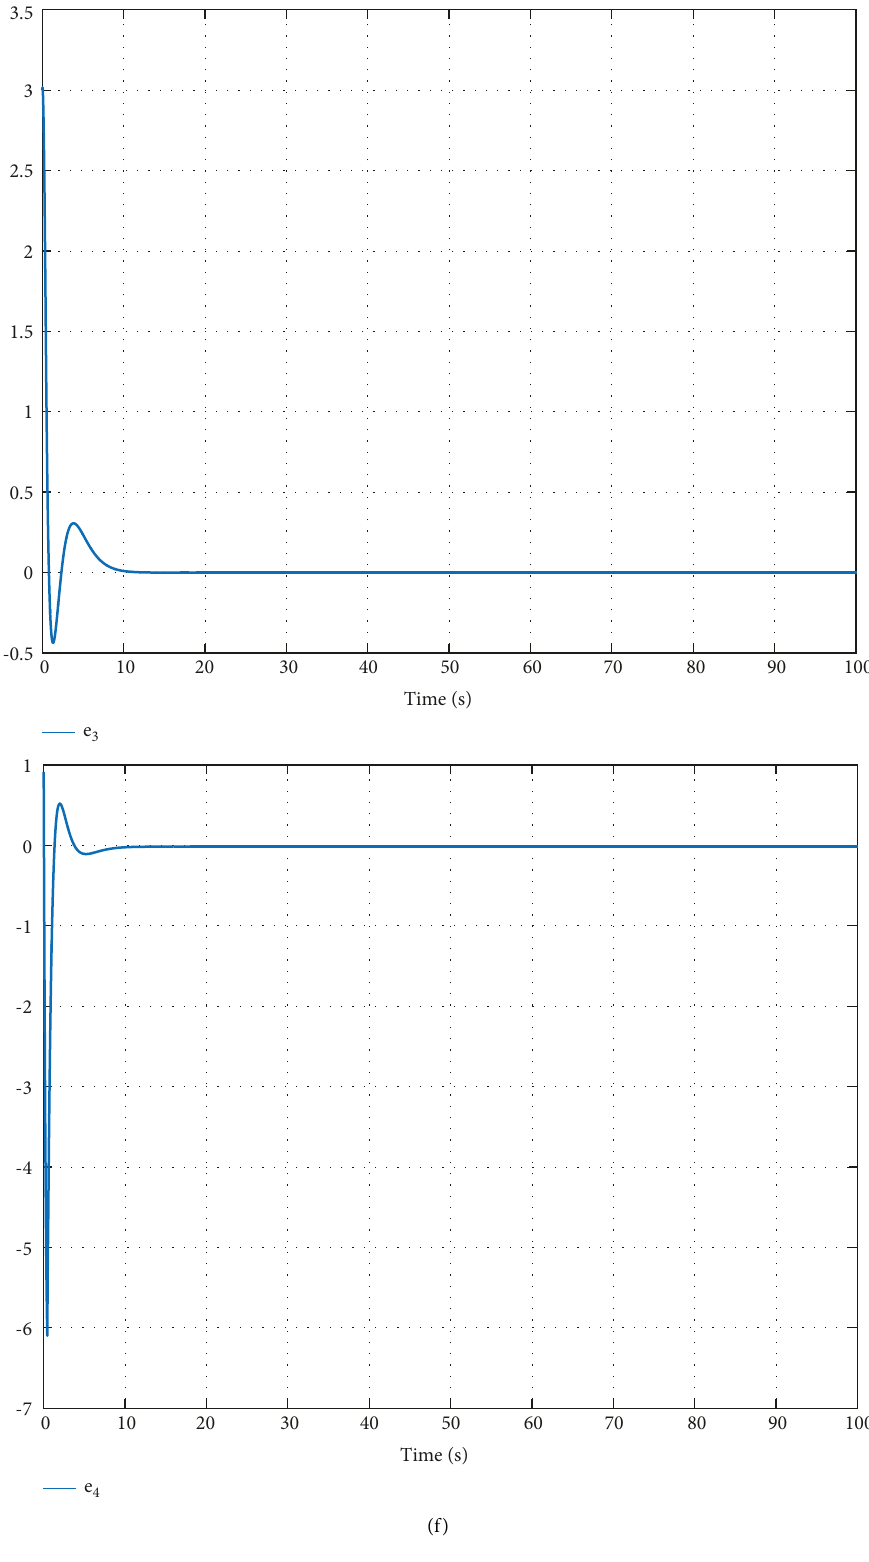
( 0 ) , y ( 0 ) � ( 2 , − 1 )] . (d) Synchronization 3 3 ( 0 ) , y ( 0 ) � (− 3 , − 4 )] . (e), (f) Time history of the errors 4 4